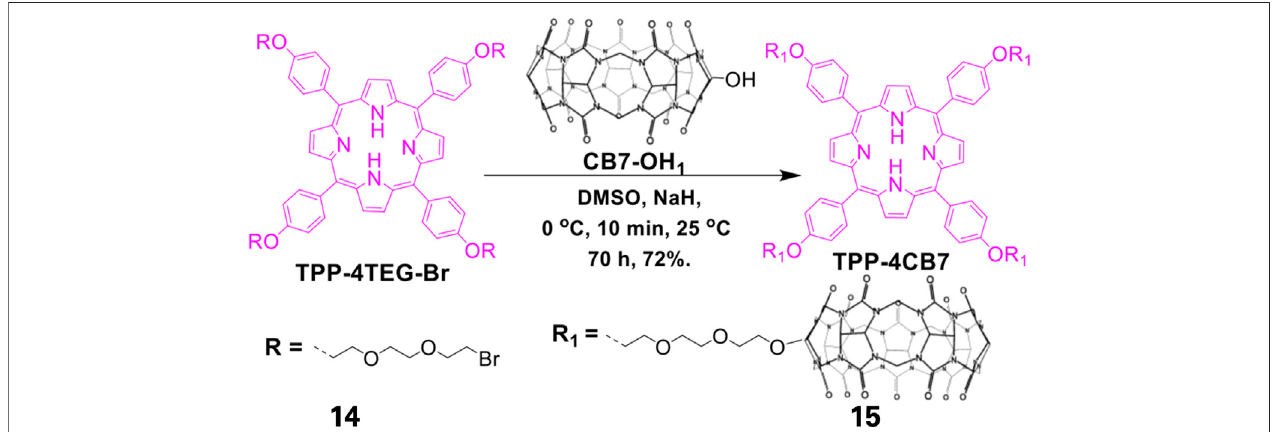
FIGURE5| SynthesisofCucurbit[7]uril-linkedPorphyrin-basedcomplex.ThefreeTPPporphyrinwas fi rstconjugatedtohydrophilicpolyethyleneglycolafterwhich the resulting conjugate was complexed with that of Cucurbit[7]uril. This reaction resulted in a self-assembling amphiphilic system. Adapted with permission from Özkan et al. (2019).